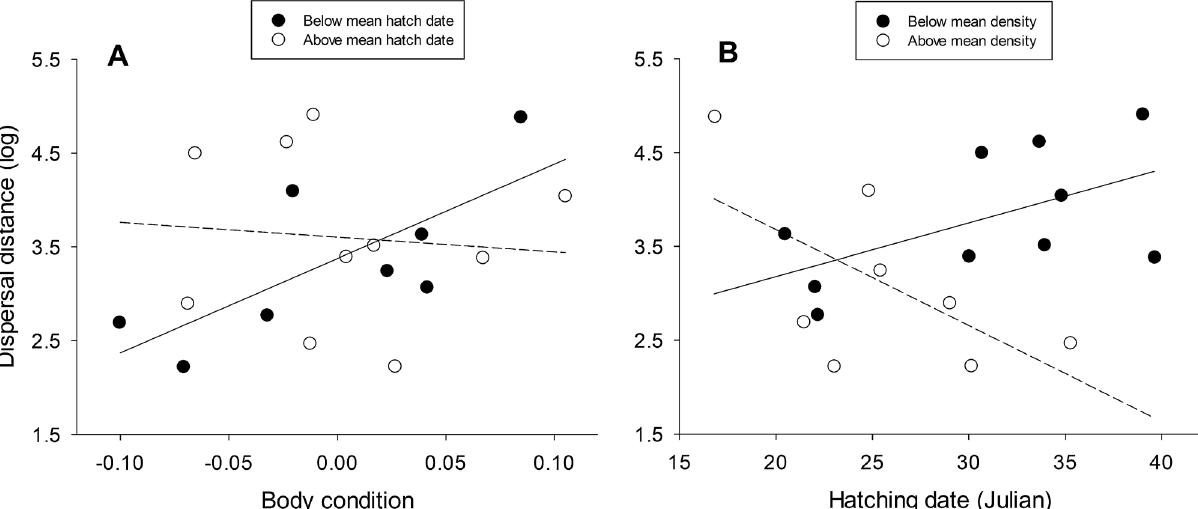
Figure 5. Relationship between dispersal distance (log scale) and body condition for Egyptian vulture females hatched early and late ( A ) and between dispersal distance and hatching date for females born at low and high densities ( B ) at the local scale (Ebro